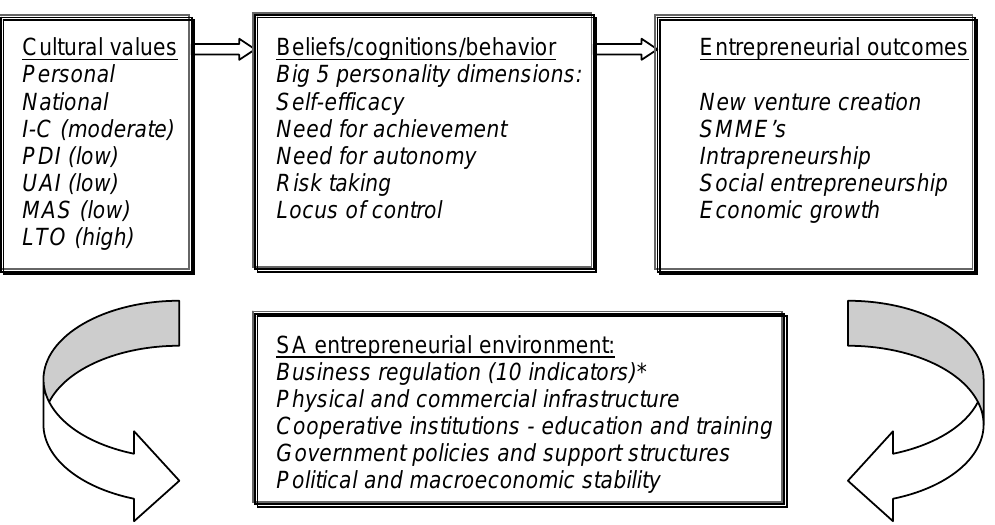
Figure 3: Framework of selected components to explain entrepreneurship context from a cultural